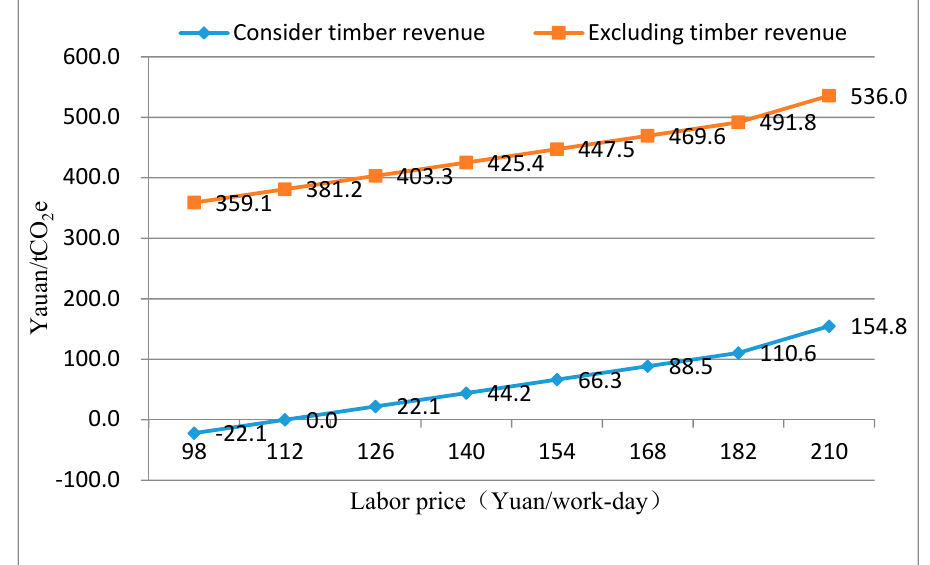
Figure 3. The carbon sink cost under different labor prices.